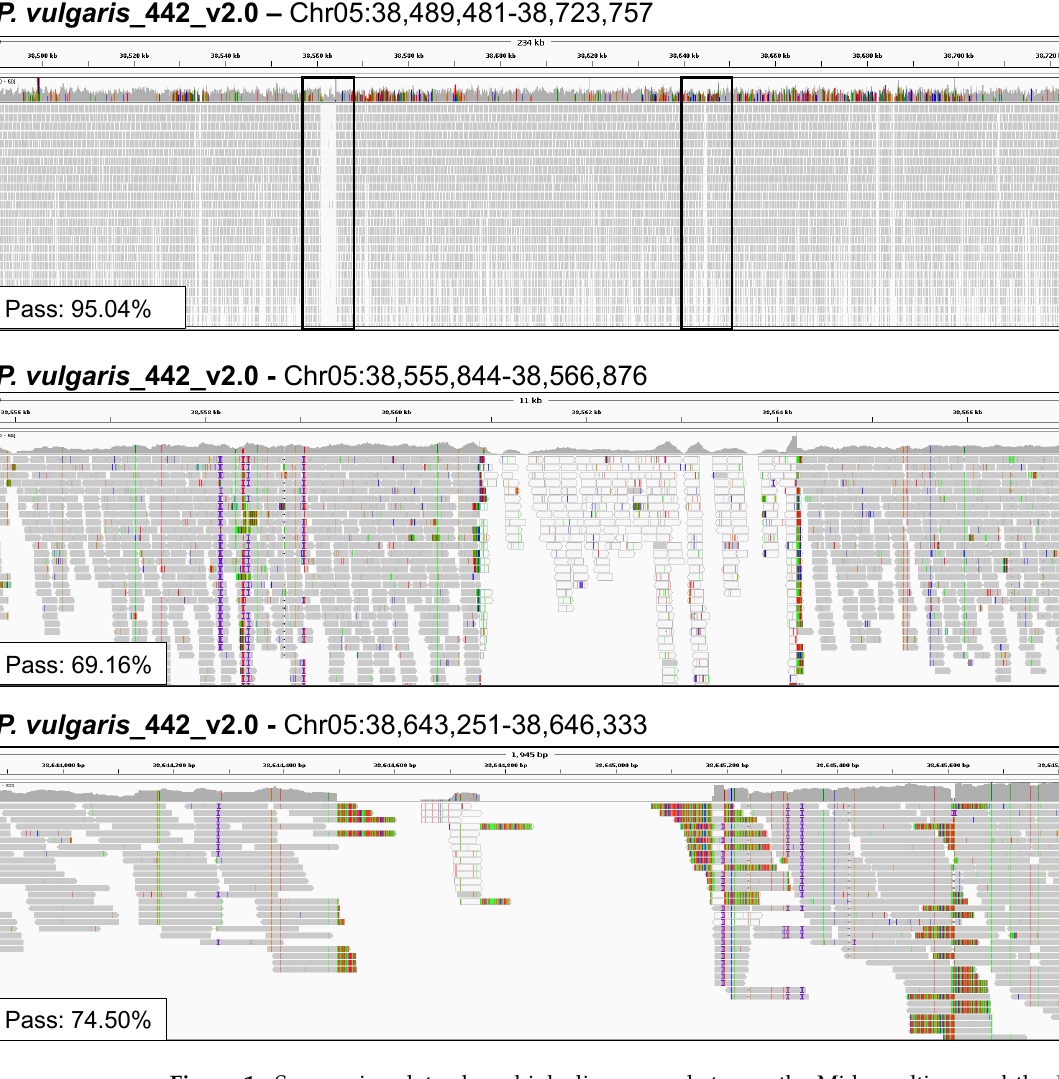
Figure 1. Sequencing data show high divergence between the Midas cultivar and the P. vulgaris reference genome within the pod-shattering region. ( A ) Integrative Genome Browser Visualization